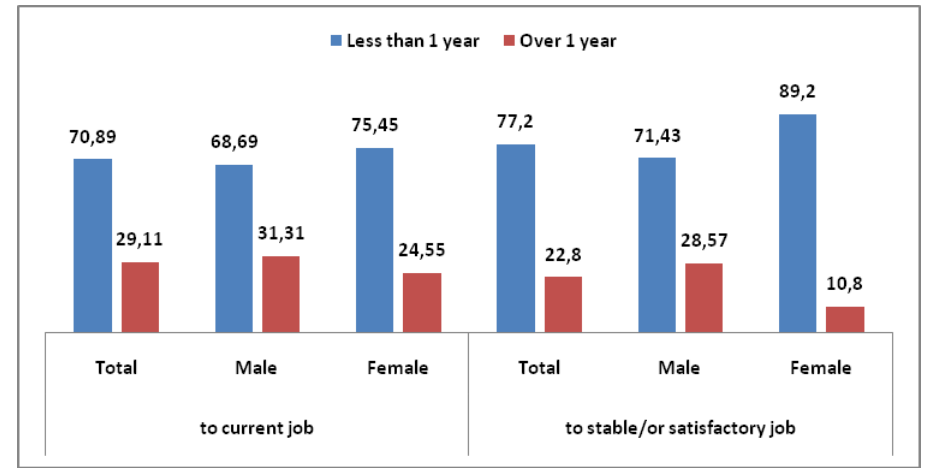
Figure 10: Youth who move from the first job to current job by length of transition and gender